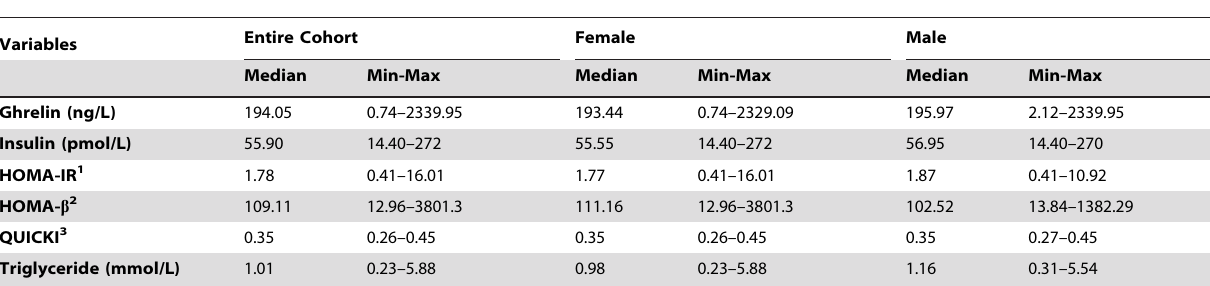
Table 2. Biochemical characteristics of data not normally distributed.